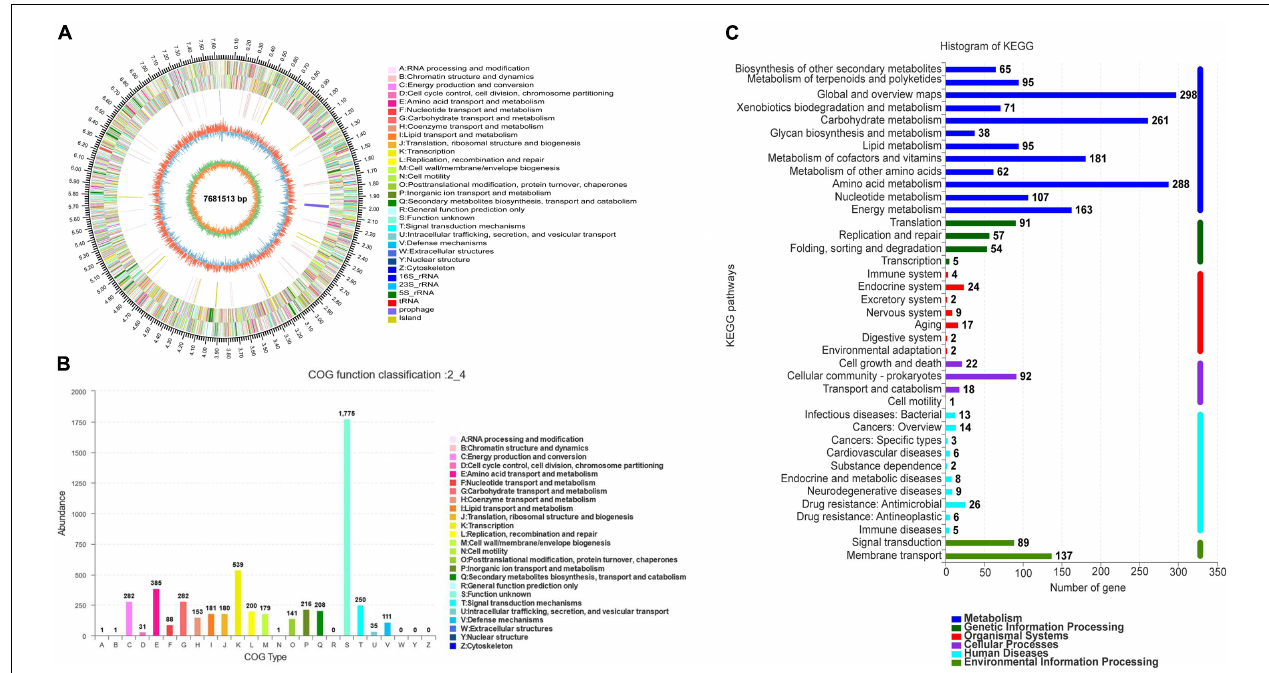
FIGURE 5 | Genome information and function annotation of strain SCA2-4 T . (A) Circular map of strain SCA2-4 T genome. From outside to center, ring 1 was the mark of genome size. Rings 2 and 3 represented CDS on forward/reverse strand. Different colors indicated the functional category of CDS. Ring 4 was tRNA and rRNA. Ring 5 showed the G + C content. The outward red part indicated that the GC content of this region was higher than the average GC content of the whole genome. The inward blue part indicated that the GC content of this region was lower than the average GC content of the whole genome, followed by G + C skew in ring 6. (B) The COG annotation of strain SCA2-4 T genome. (C) The KEGG pathway annotation of strain SCA2-4 T genome.